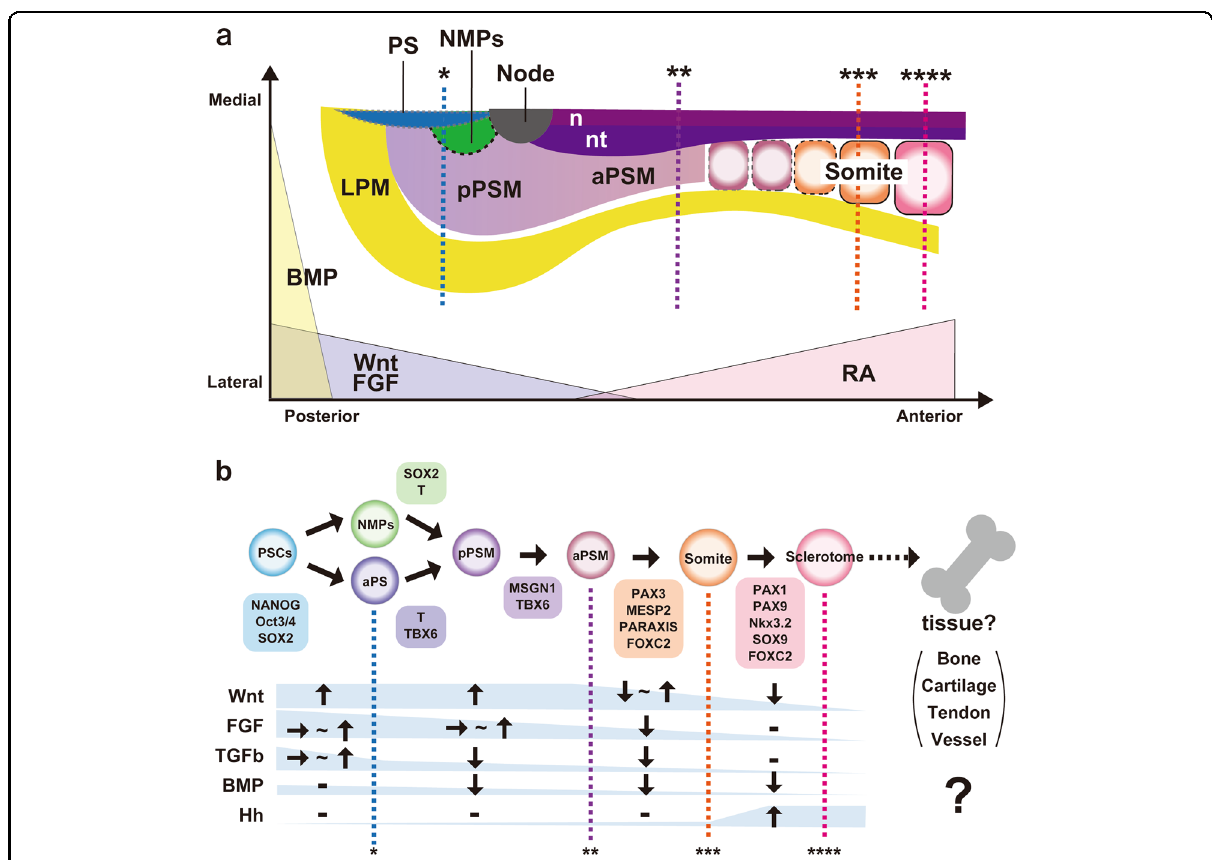
Fig. 3 Flowchart of paraxial mesodermal development and sclerotome speci fi cation. a A dorsal view of the mesoderm fate in the posterior of an amniote embryo. The paraxial mesoderm forms in the primitive streak and from NMPs. Through the elongation of the embryo axis, the PSM is located from posterior to anterior according to the body axis produced by competing gradients of Wnt, FGF, and RA. The anterior PSM forms somite at the determination front depending on the FGF gradient and Notch signaling. b A fl owchart of the in vitro differentiation process from PSCs to sclerotomes, with critical inducers and speci fi c markers in each stage. In the future, a next step will be to differentiate the induced sclerotome into sclerotome derivatives, such as bone, tendon, and vessels. RA retinoic acid, NMP neuromesodermal progenitor, PS primitive streak, aPS anterior primitive streak, pPSM posterior presomitic mesoderm, aPSM anterior presomitic mesoderm, nt neural tube, n notochord, LPM lateral plate mesoderm. Asterisks in each of the differentiation stages in a correspond to the stages highlighted by asterisks in b